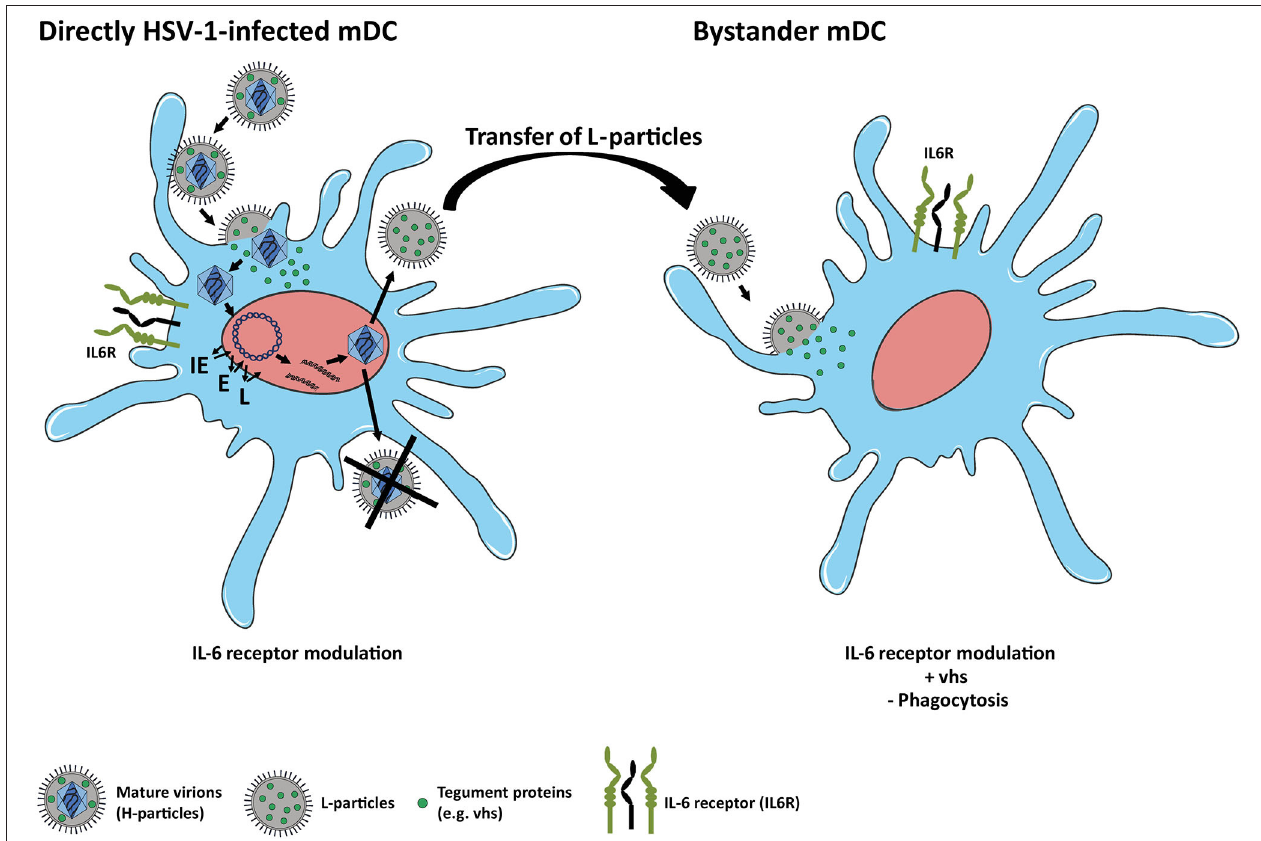
FIGURE 7 | Scheme of IL6R modulation on HSV-1-infected and bystander mDCs. Left: HSV-1 efficiently infects mDCs and modulates IL6R expression on directly-infected mDCs. In mDCs, the production of infectious mature virions (H-particles) is inhibited upon an HSV-1 infection, since newly assembled capsids are trapped within the nucleus. Thus, only capsid-less non-infectious L-particles can be generated by HSV-1-infected mDCs. Right: L-particles are released by HSV-1-infected mDCs and modulate bystander mDCs, e.g., IL6R expression. In this regard, tegument proteins, such as vhs, which are also associated with L-particles, are capable of entering and interfering with bystander